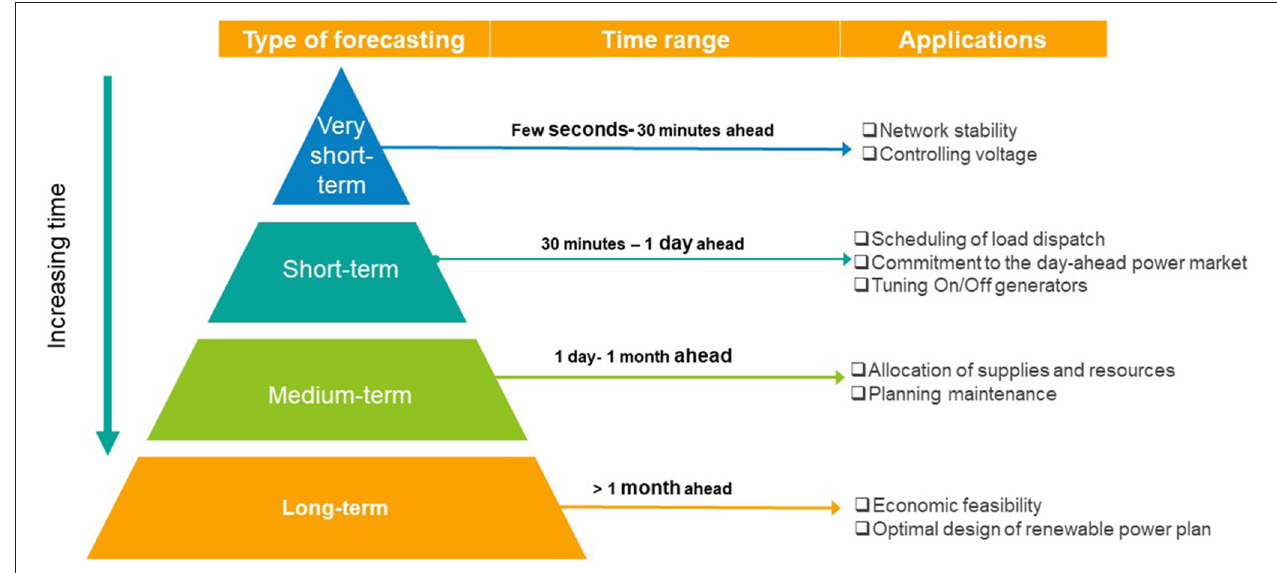
FIGURE 1 | Forecasting time horizons (Santhosh and Venkaiah,